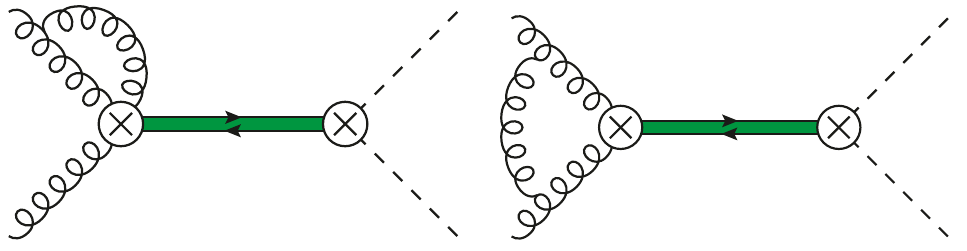
Figure 8 . nrNLO diagrams involving collinear (left) and ultrasoft (right) gluon radiation. Both loop integrals are scaleless and vanish in dimensional